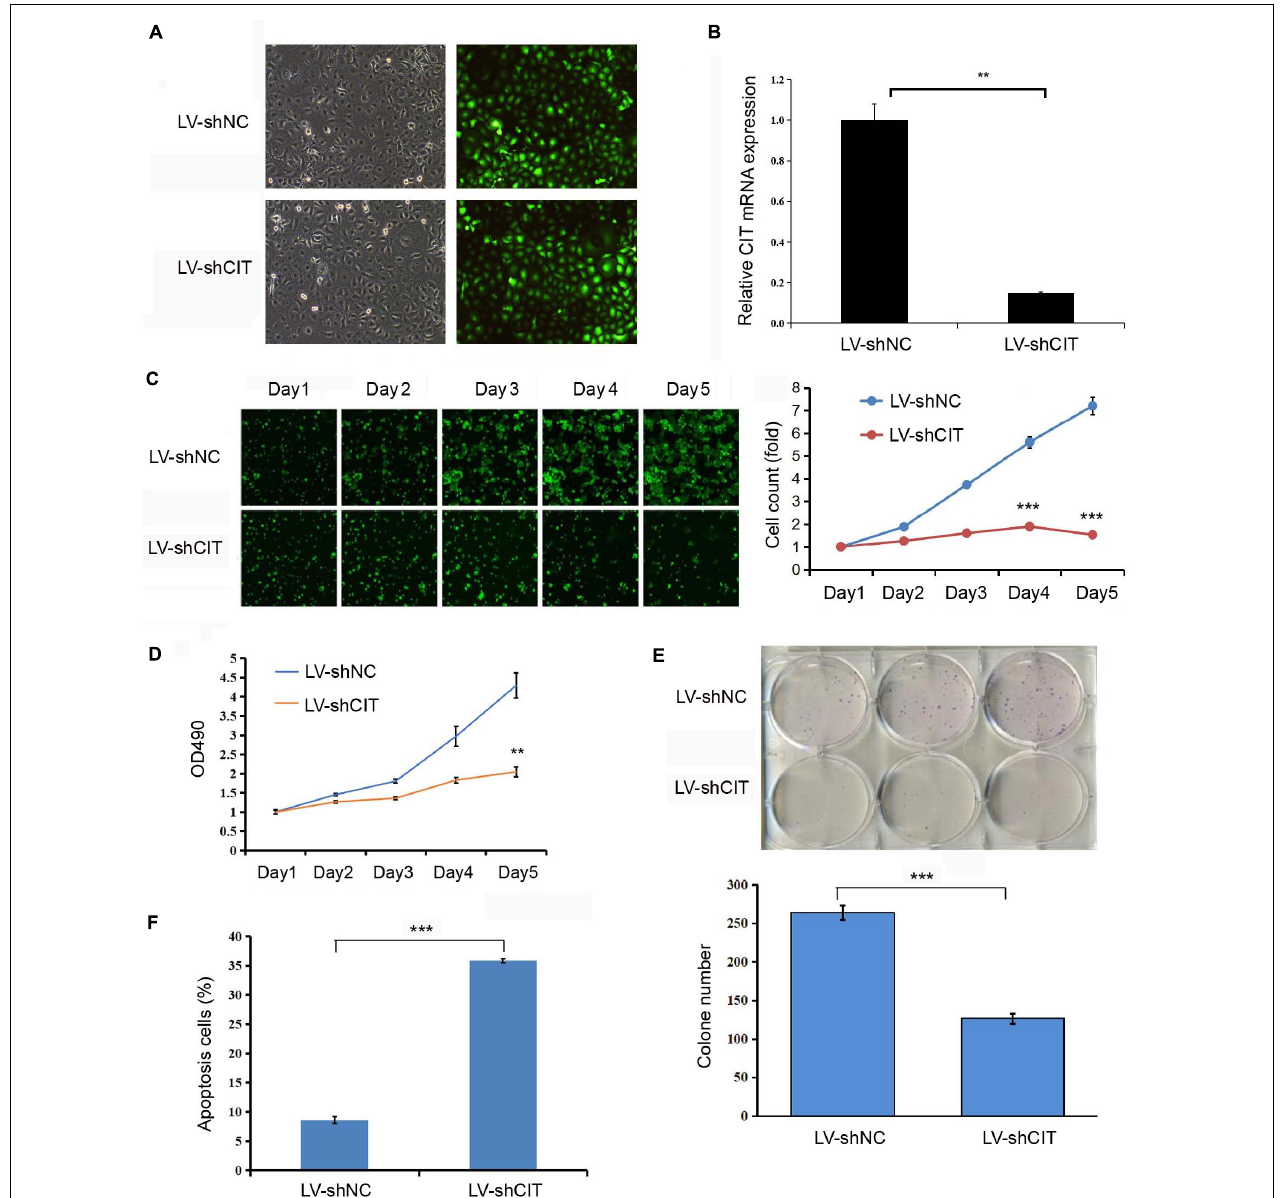
FIGURE 2 | Effect of knockdown of CIT on Eca-109 cell proliferation and apoptosis in vitro . (A) Infection of Eca-109 cells with LV-shCIT or LV-shNC. The efficiency of transfection was monitored with co-expression of EGFP. (B) The relative expression level of CIT mRNA in LV-shCIT or LV-shNC transfected Eca-109 cells. (C) Images and Celigo cell count of fluorescent LV-shCIT or LV-shNC-transfected Eca-109 cells 5 days after transfection. (D) MTT assay was conducted to record the fold change in absorbance at 490 nm within 5 days after transfection. (E) Colony formation assay of LV-shCIT or LV-shNC Eca-109 cells. (F) Flow cytometry histograms showing the percentage of apoptotic cells after transfection. ** P < 0.01 and *** P <